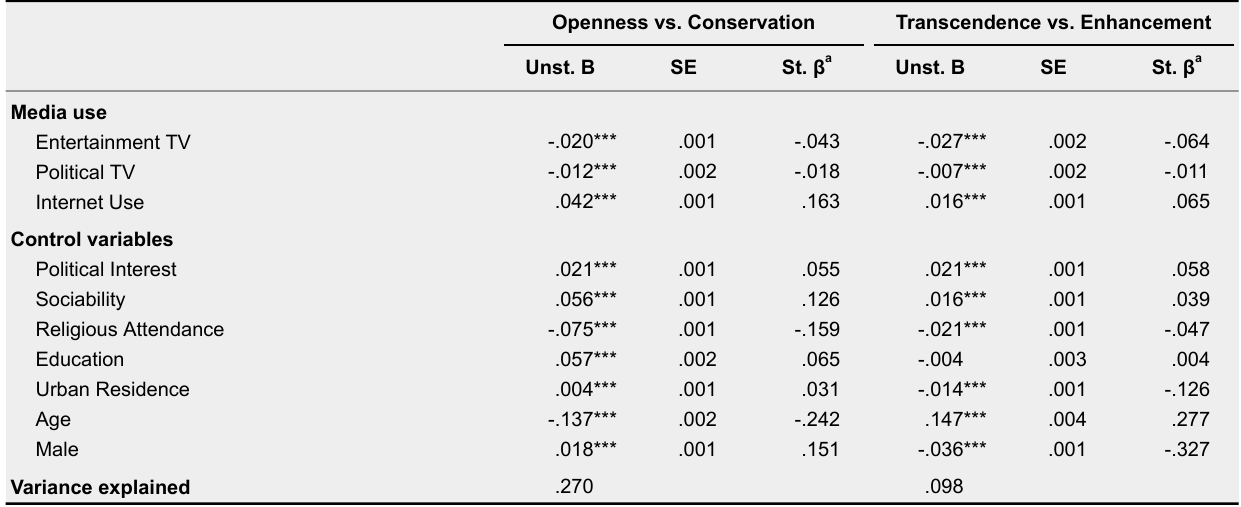
Estimated Effects in Within-Level Value Equations (N = 37,704)